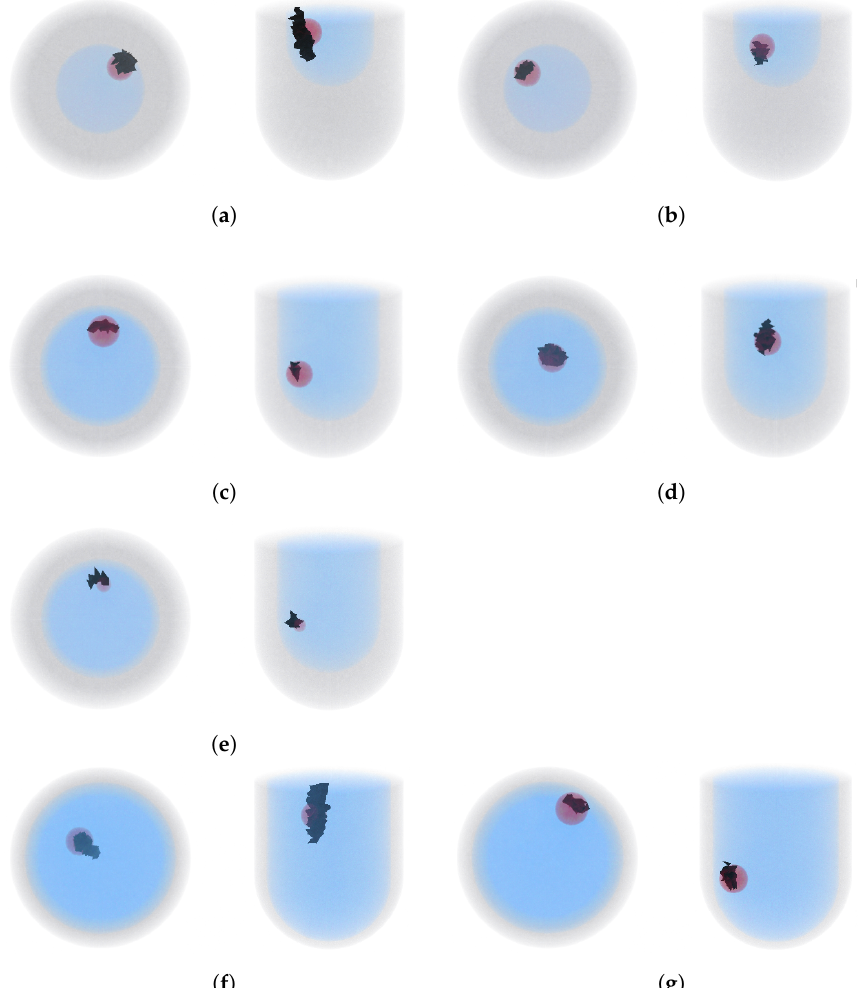
Figure 7. CSI reconstructions for two different tumor positions, when prior information has been generated by our neural network. +z projection ( left ) and +x projection ( right ) are shown. ( a , b ) show T1 and T2 for the small fibroglandular case; ( c – e ) show T1 (9 mm), T2, and the T1 (4.5 mm) for the medium fibroglandular case; ( f , g ) show T1 and T2 for the large fibroglandular case. Adipose (grey), fibroglandular (blue), and tumor (red) show the true geometry of the breast model tissues. The 85% thresholded contrast representing the reconstructed tumor is shown in